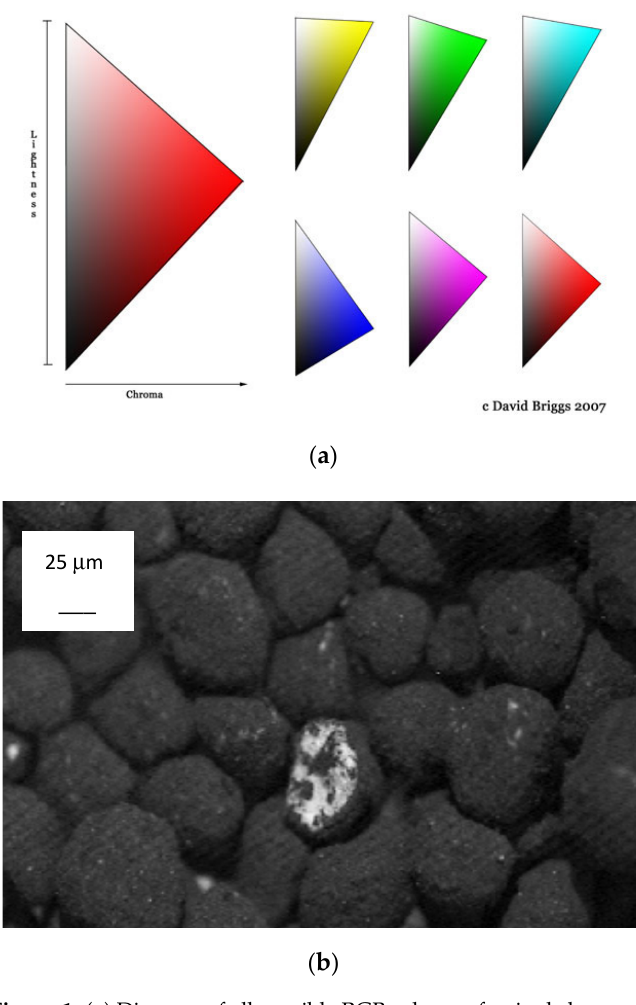
Figure 1. ( a ) Diagram of all possible RGB colours of a single hue angle, showing variations in the range of possible chroma with lightness. Reprinted with permission from Ref. [5], 2007. ( b ) Particles rejected on 60 µ m sieve of the black pigment 0.1Co 3 O 4 .0.1Cr 2 O 3 @TiO 2 obtained by dry powder coating